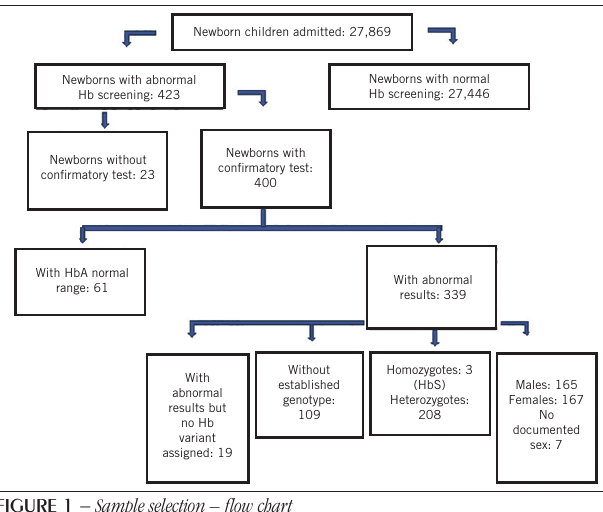
figurE 1 − Sample selection – flow chart Flow chart showing the process followed by every newborn in our institution and then used in the present study to select our study